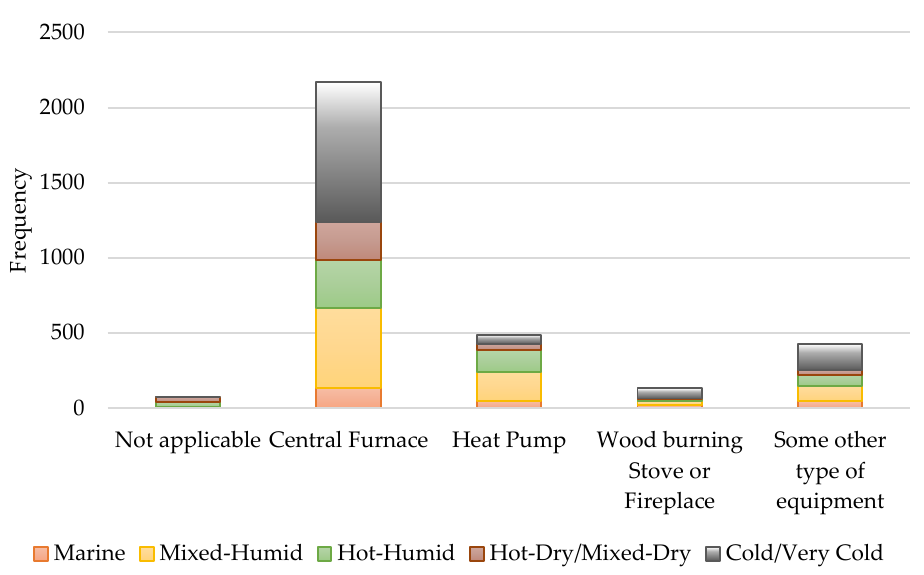
Figure 8. Type of main space heating equipment per climate zone (total n = 3288).